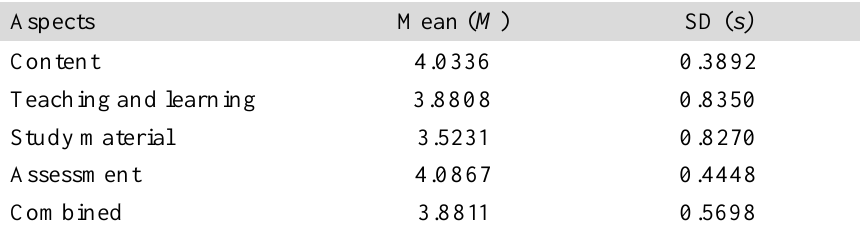
Aggregated Feedback on Aspects of the